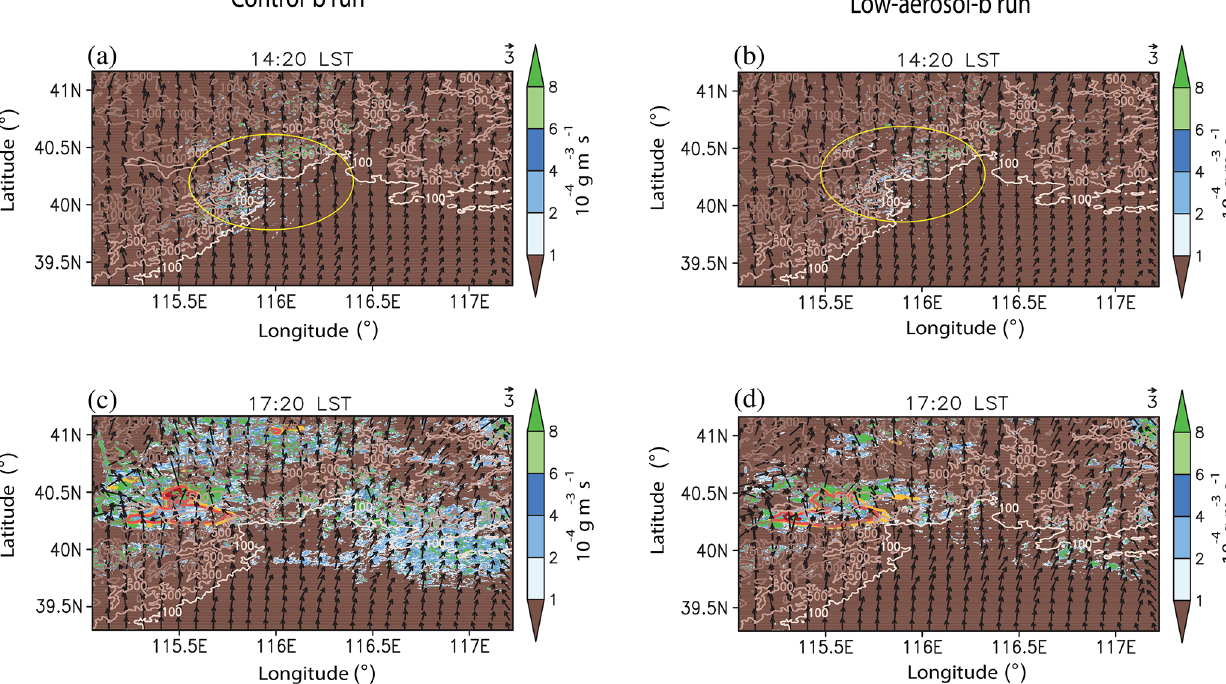
rates are paired at each column and time step. Then,